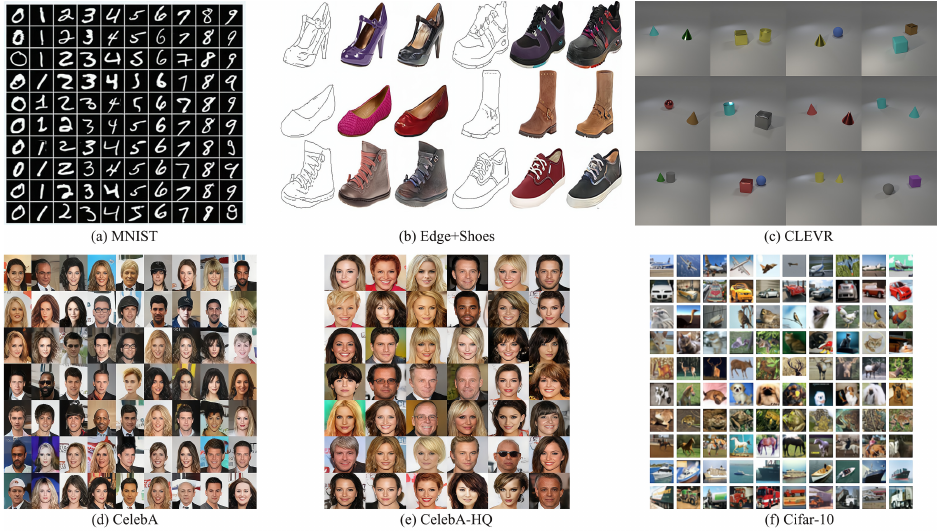
Figure 2. The datasets used in this